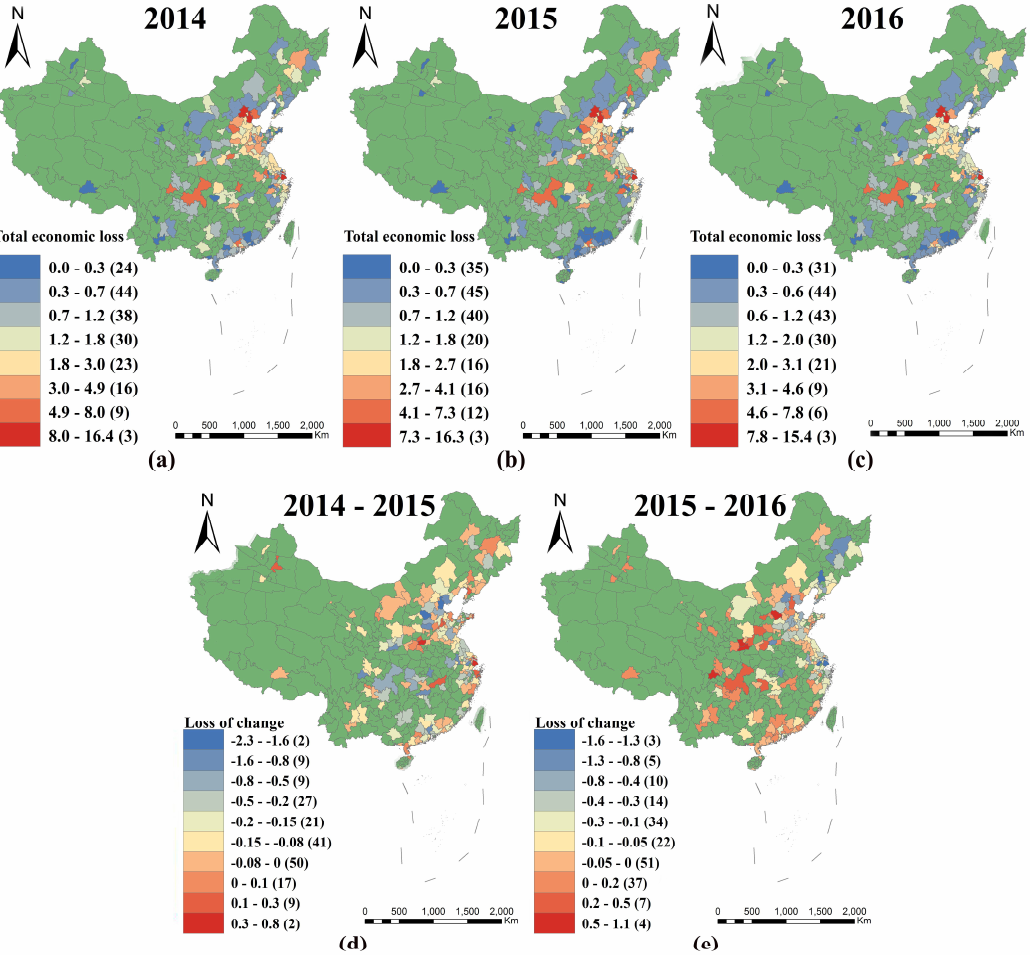
Figure 6. Spatial distribution of PM 2.5 -related economic losses in the lower bounds in 2014 ( a ); 2015 ( b ); and 2016 ( c ). Distribution of changes in PM 2.5 -related economic losses in the lower bounds for the periods 2014–2015 ( d ) and 2015–2016 ( e ).